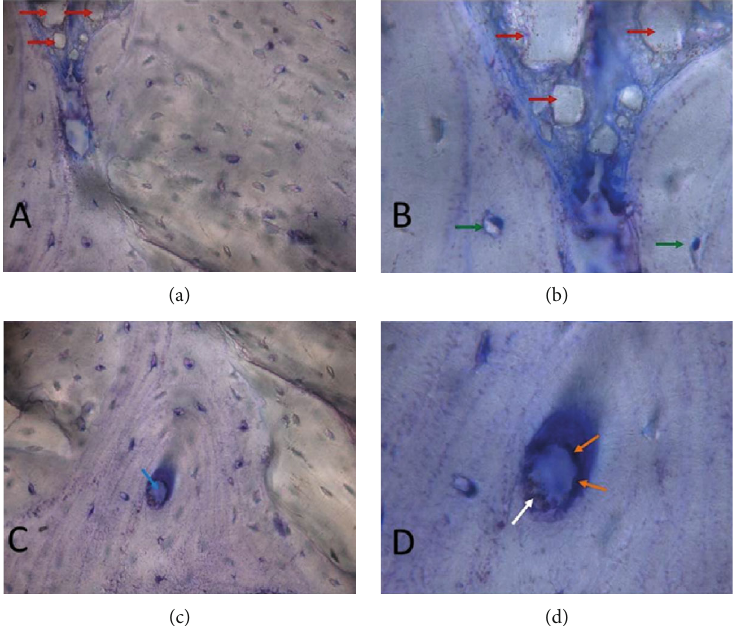
Figure 7: (a) Image of a grafted material interface (red arrow) and cortical bone. It is clearly shown the formation of cortical bone with osteocytes; (b) enlarged image of (a). Grafted material (red arrow). Osteocytes present in the gaps (green arrow); (c) well-formed Haversian system: note the arrangement of concentric lamellae, with the central channel of Havers (blue arrow). Osteocytes homogeneously distributed, demonstrating the usual architecture of cortical bone; (c) enlarged image of (d). In detail, the Havers channel, with endosteum (orange arrow) and red blood cells (white arrow).